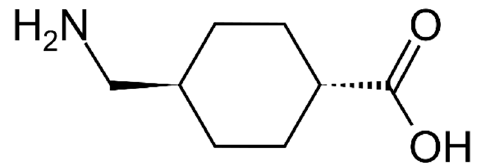
Figure 1. Molecular structure of tranexamic acid.